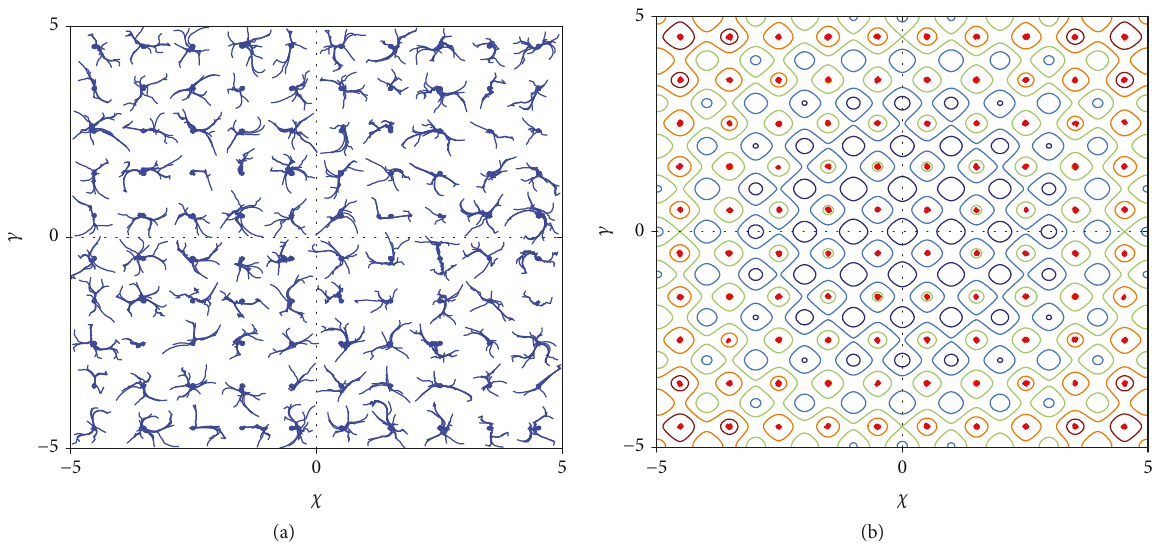
Figure 2: Iterative trajectories and the fi nal butter fl y distribution of the function f (b) the fi nal distribution of butter fl ies by CABMO.